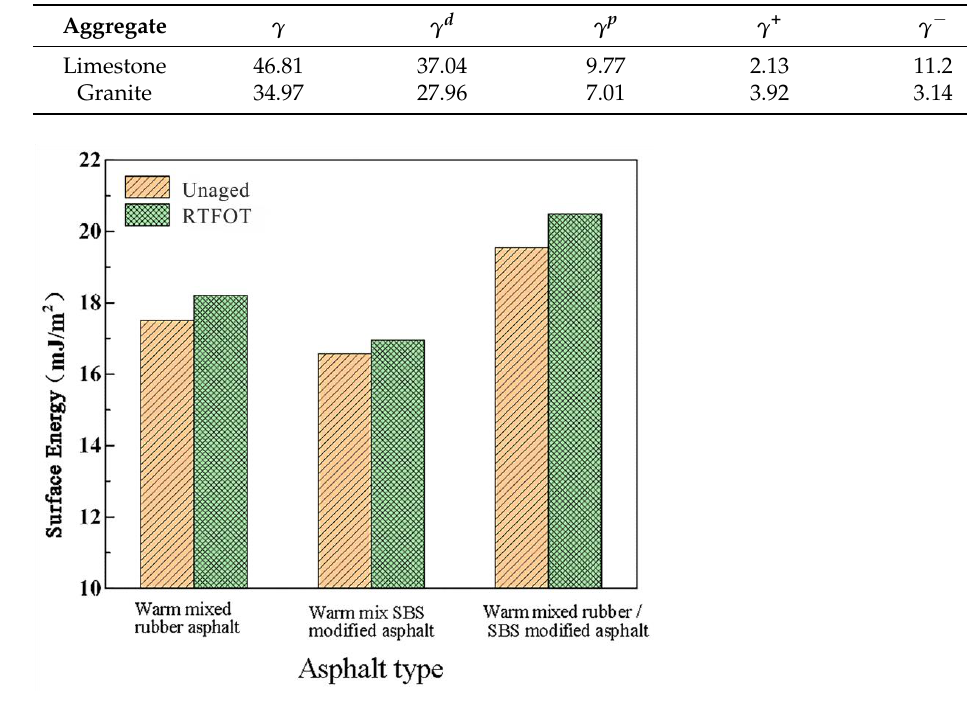
Figure 3. The contact angle of asphalt and polar liquid: ( a ) Distilled water, ( b ) Glycerol, and ( c ) Formamide. Table 9. Surface free energy of aggregate (mJ/m 2 ).